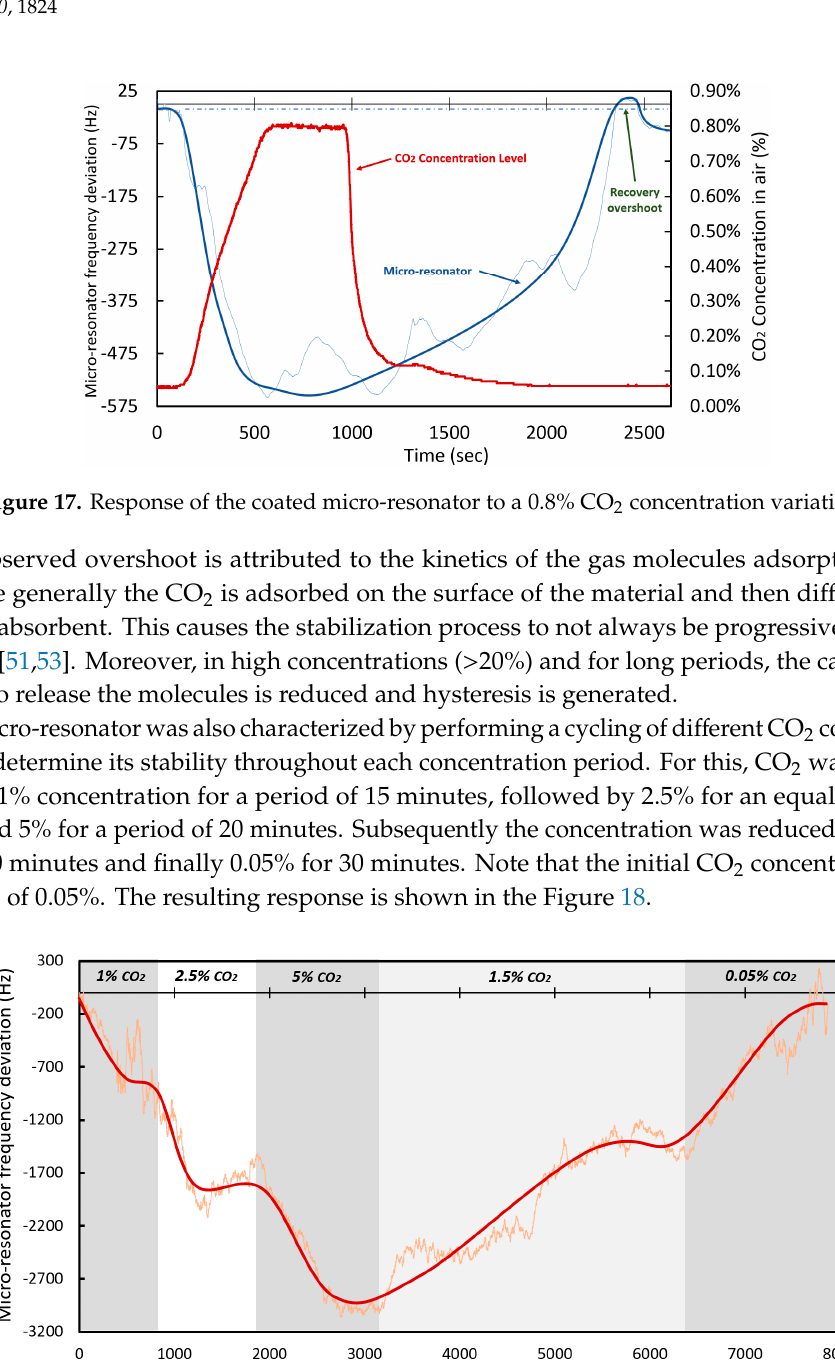
Figure 18. Behavior of the micro-resonator over time at different concentrations of CO 2 .